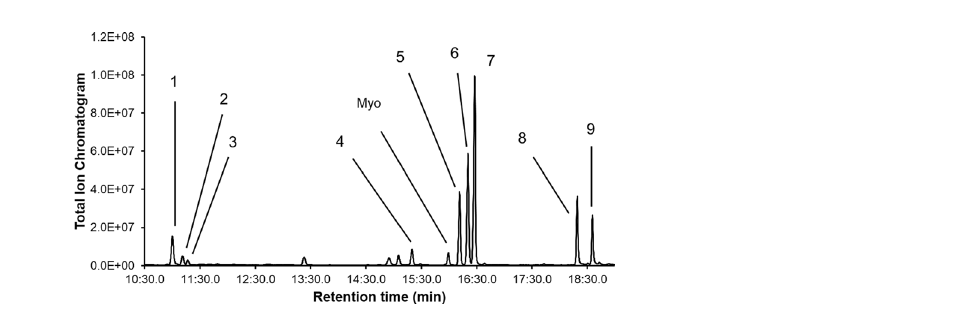
Figure 3. Total ion chromatogram of the purified polysaccharide of B. mori pupae. 1, l-rhamnose; 2, l-fucose; 3, l-arabinose; 4, d-glucuronic acid; 5, d-mannose; 6, d-glucose; 7, d-galactose; 8, N-acetyl-d-glucosamine; 9,